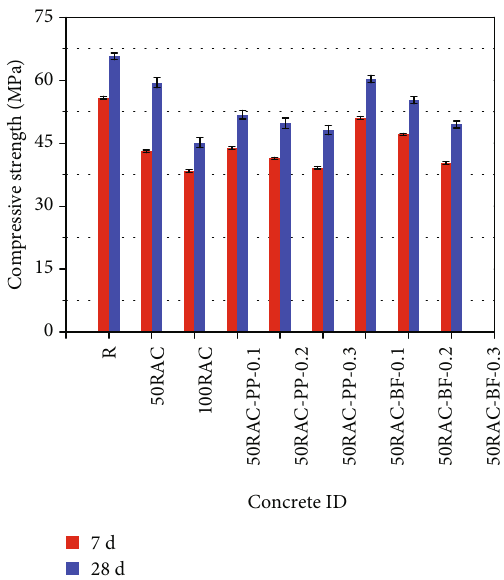
Figure 7: Compressive strength of